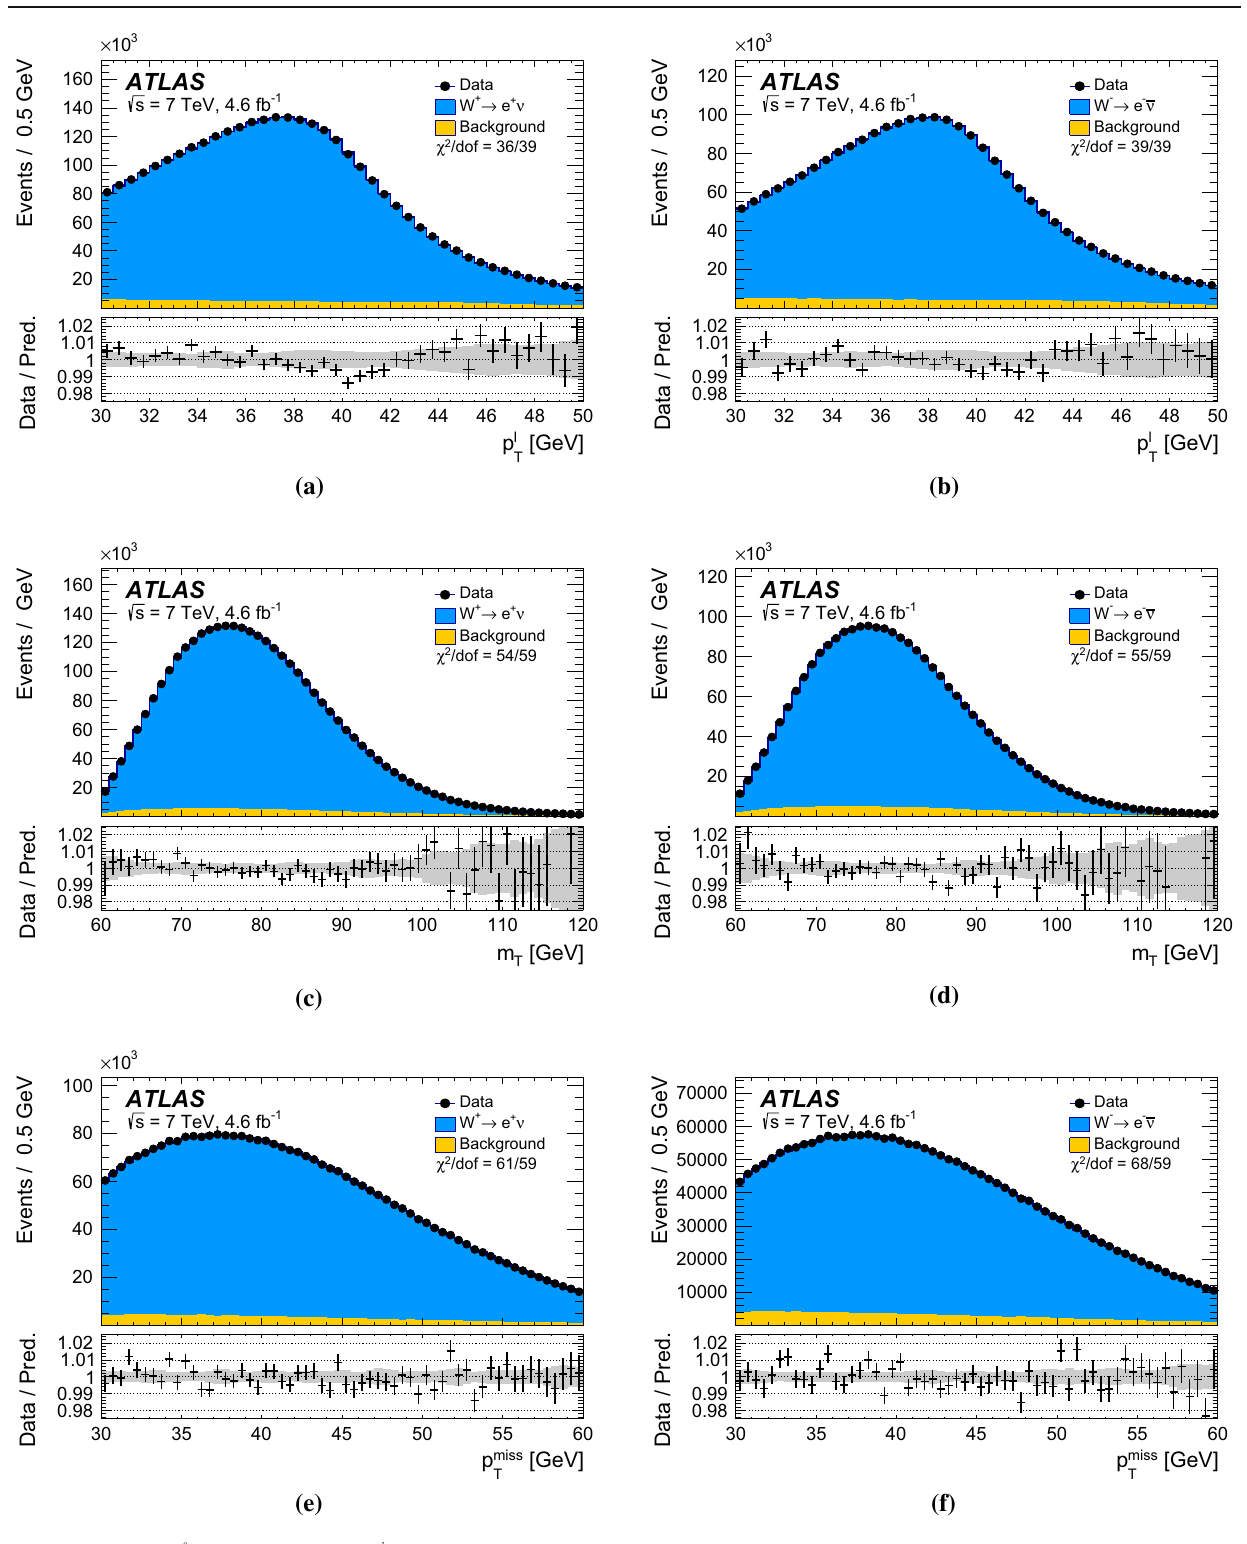
Fig. 24 The a , b p (cid:7) show the data-to-prediction ratios, the error bars show the statistical , c , d m T , and e , f p miss distributions for a , c , e T T W + events and b , d , f W − events in the electron decay channel. The uncertainty, and the band shows the systematic uncertainty of the pre- diction. The χ 2 values displayed in each figure account for all sources data are compared to the simulation including signal and background contributions. Detector calibration and physics-modelling corrections of uncertainty and include the effects of bin-to-bin correlations induced are applied to the simulated events. For all simulated distributions, m W by the systematic is set according to the overall measurement result. The lower panels